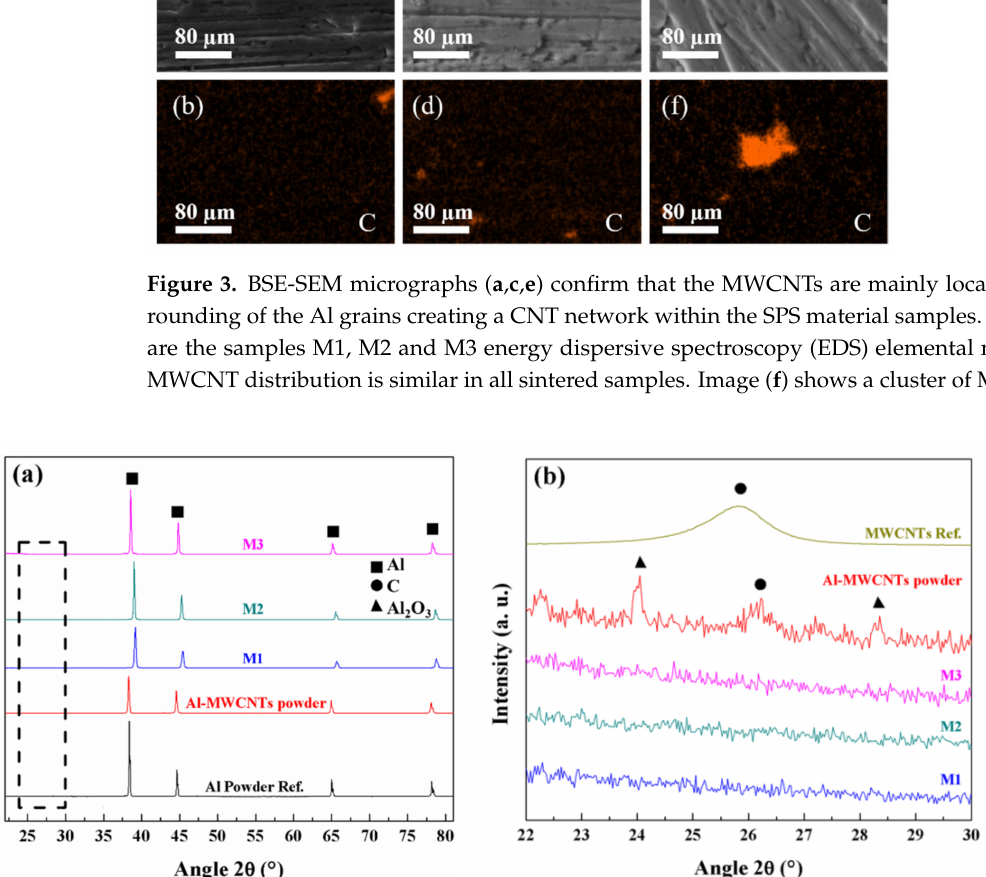
Figure 4. ( a ) XRD diffractograms for Al-MWCNTs powder and for the sintered Al-based nanocomposites M1, M2, and M3 samples, and the characteristic reflection planes for Al powder. ( b ) Zoom-in view of the Al-based nanocomposite M1, M2, and M3 samples showing the characteristic (002) graphitic plane. The MWCNTs and Al diffractograms were included and scaled for comparison